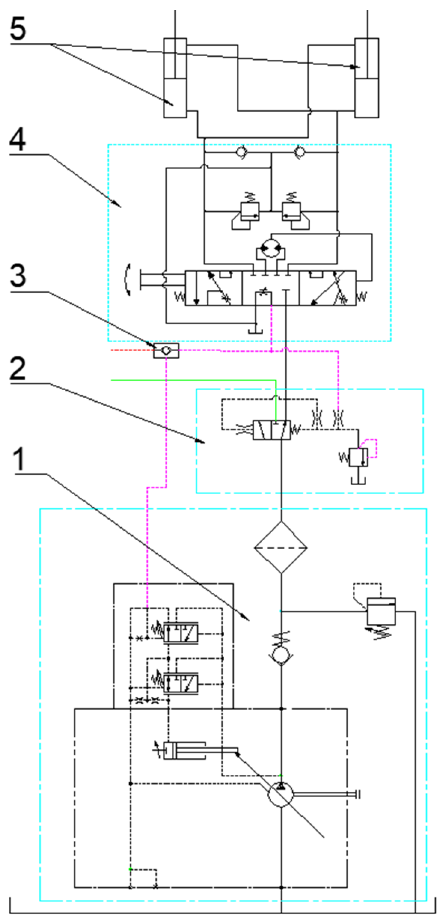
Figure 1. Schematic Diagram of Loader Hydraulic Steering System: 1-Load sensing variable pump; 2-Priority valve; 3-Shuttle valve; 4-Load sensing hydrostatic steering unit; 5-Cylinder.